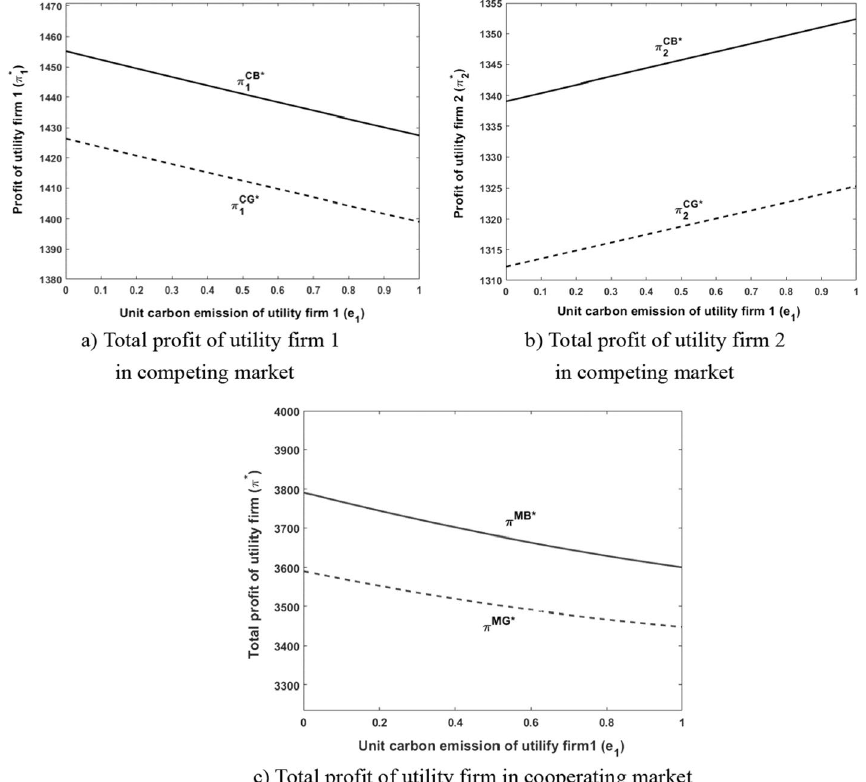
Fig. 5 Impact of unit carbon emission on